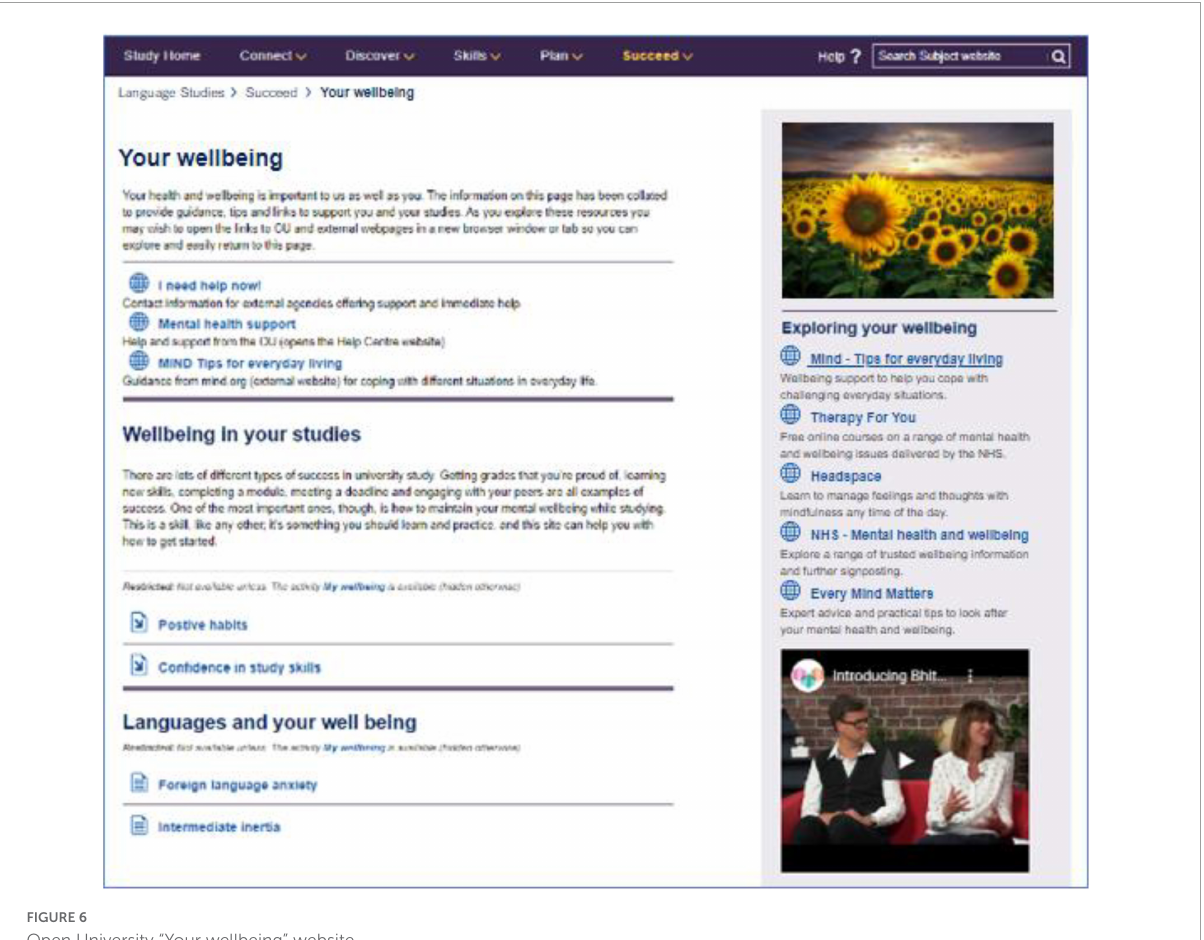
FIGURE6 Open University “Your wellbeing”